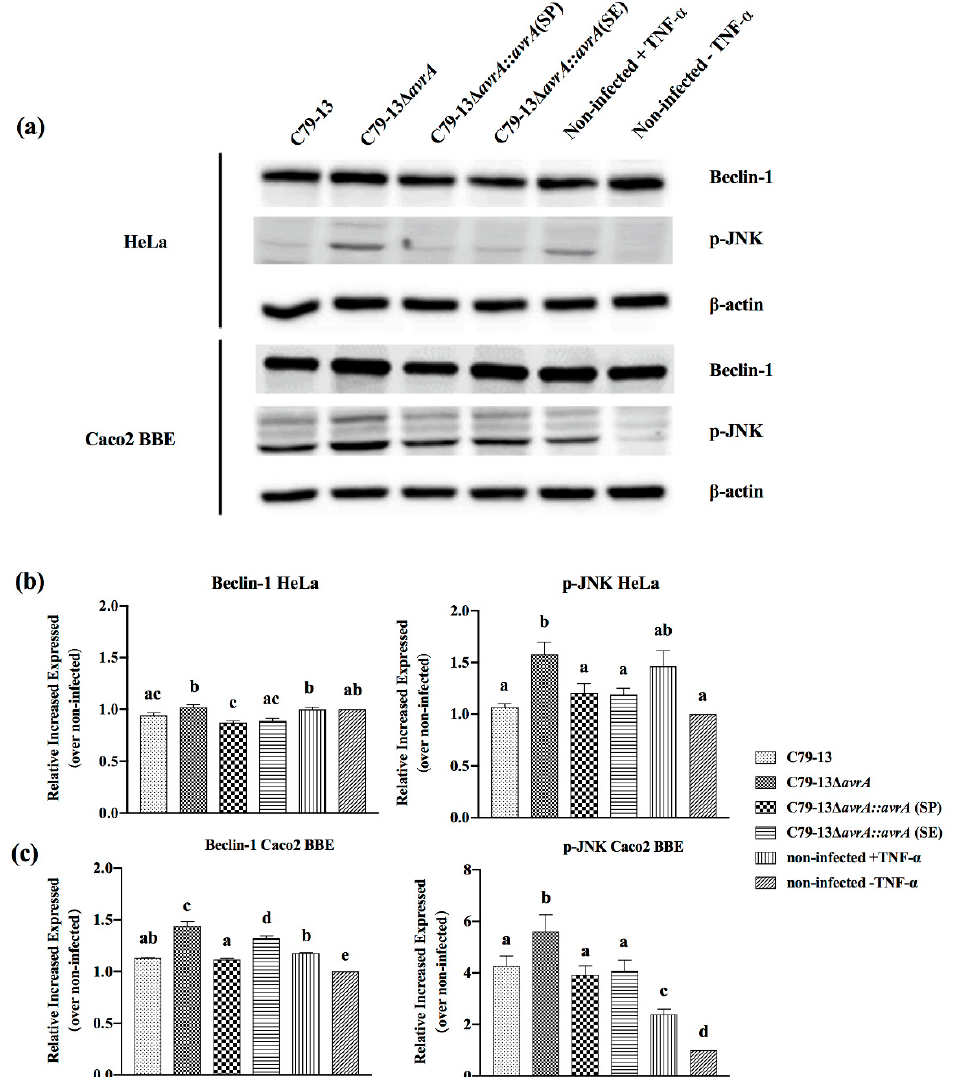
Figure 5. SP-AvrA inhibits the p-JNK and Beclin-1 pathways in S . Pullorum-infected cells. HeLa ( b ) or Caco2 BBE cells ( c ) were infected with different S. Pullorum strains. After 1 h post-infection and the following 15-min stimulation of TNF- α (15 ng/mL), the cell lysates were subjected to Western blot analysis with anti-p-JNK, anti-Beclin-1, or anti- β -actin antibodies (loading control) ( a ). Protein band density was analyzed by using the NIH ImageJ software. Data are presented as the mean + SD relative to control. The different letters on the error bars indicate statistically significant differences ( p < 0.05). 2.6. The SE-AvrA Displays Stronger Inhibition Ability of the JNK and Beclin-1 Pathways in S. Enteritidis- Infected Caco2 BBE Cells than That of SP-AvrA Expressed in S. Enteritidis